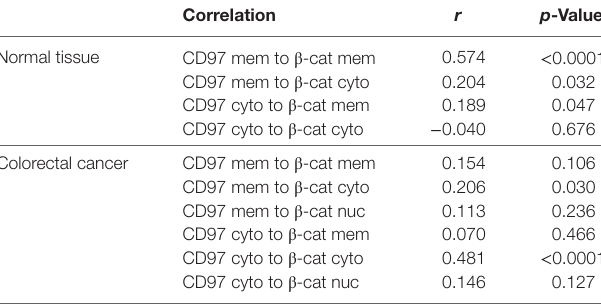
TaBle 1 | Correlation of the staining score of CD97 and β -catenin in various cellular compartments in colorectal carcinomas and the corresponding normal tissue ( n = 111 patients).